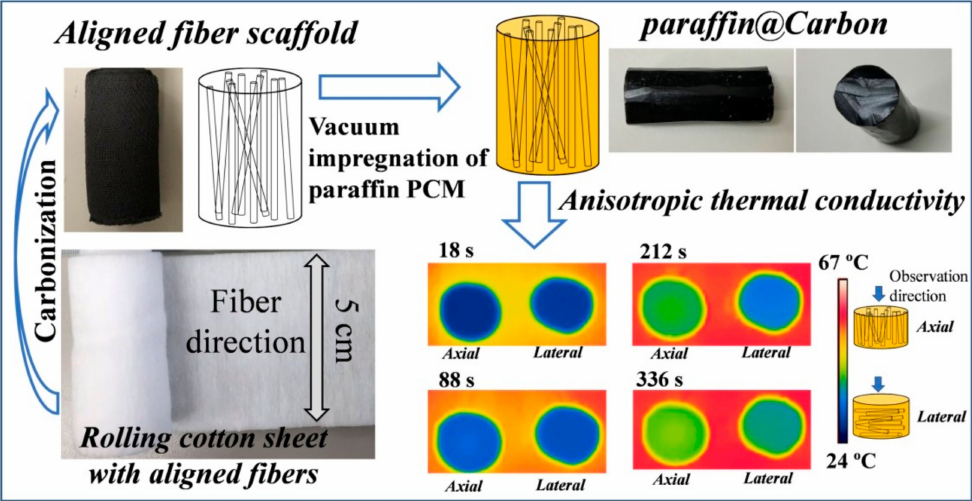
Figure 6. Schematic diagram for vacuum impregnation method to prepare carbon fiber based composites. Reprinted with permission from [63]. Copyright The Royal Society of Chemistry